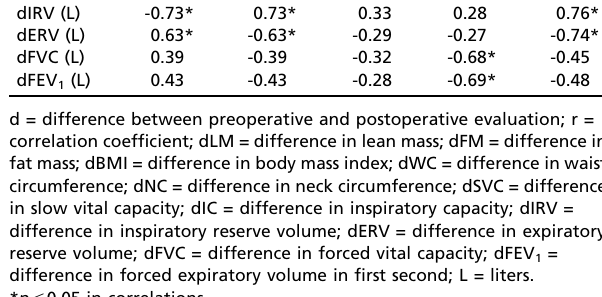
Before surgery 6 months after surgery n=24 n=24